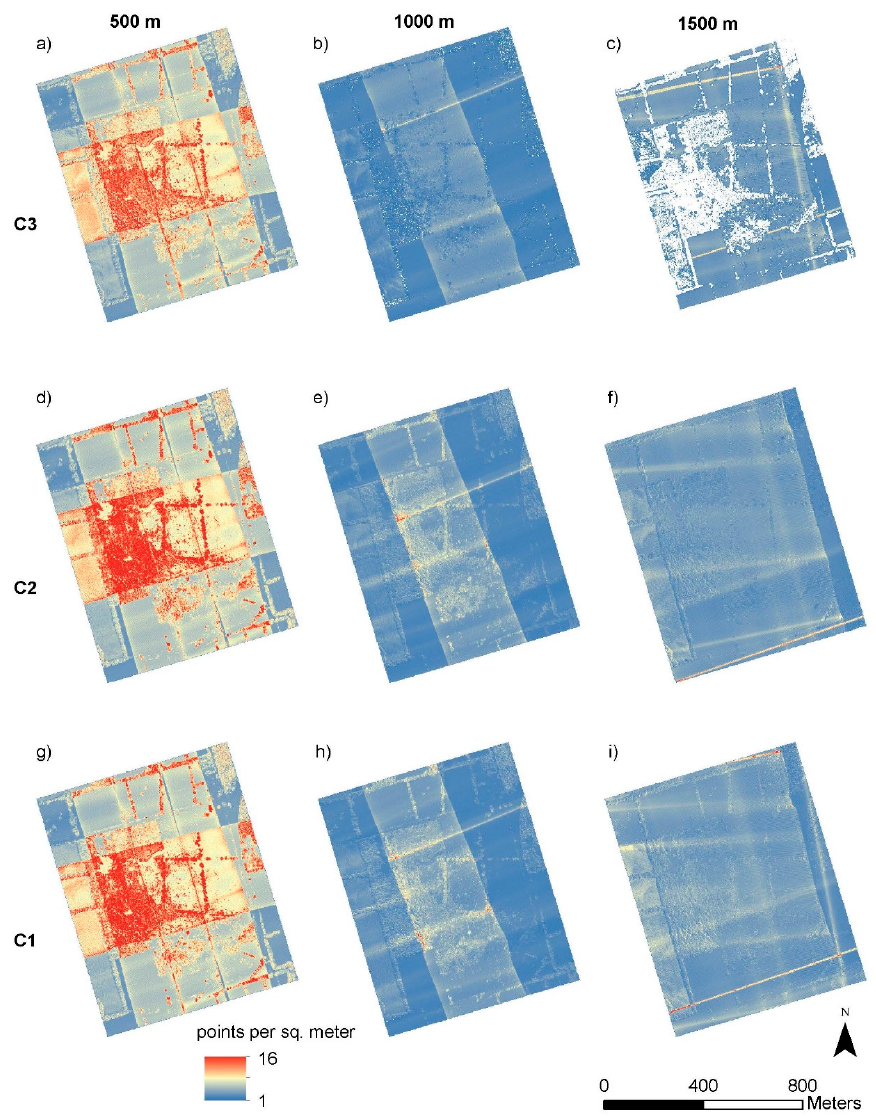
Figure 3. Point density maps from all returns at 2 m × 2 m grids. Top to bottom: C3, C2, and C1; left to right: 500 m, 1000 m, and 1500 m. White pixels represent no data. The explanation for density patterns is in the text.